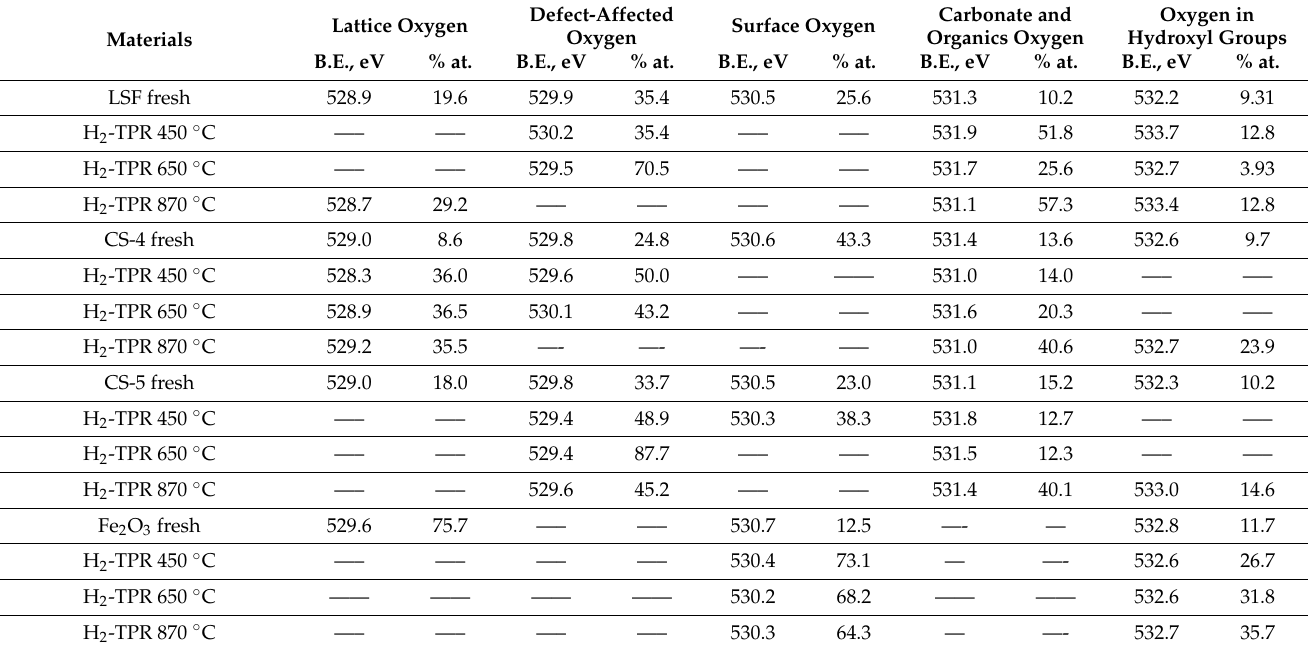
Table 7. Oxygen species detected by XPS after H 2 -TPR